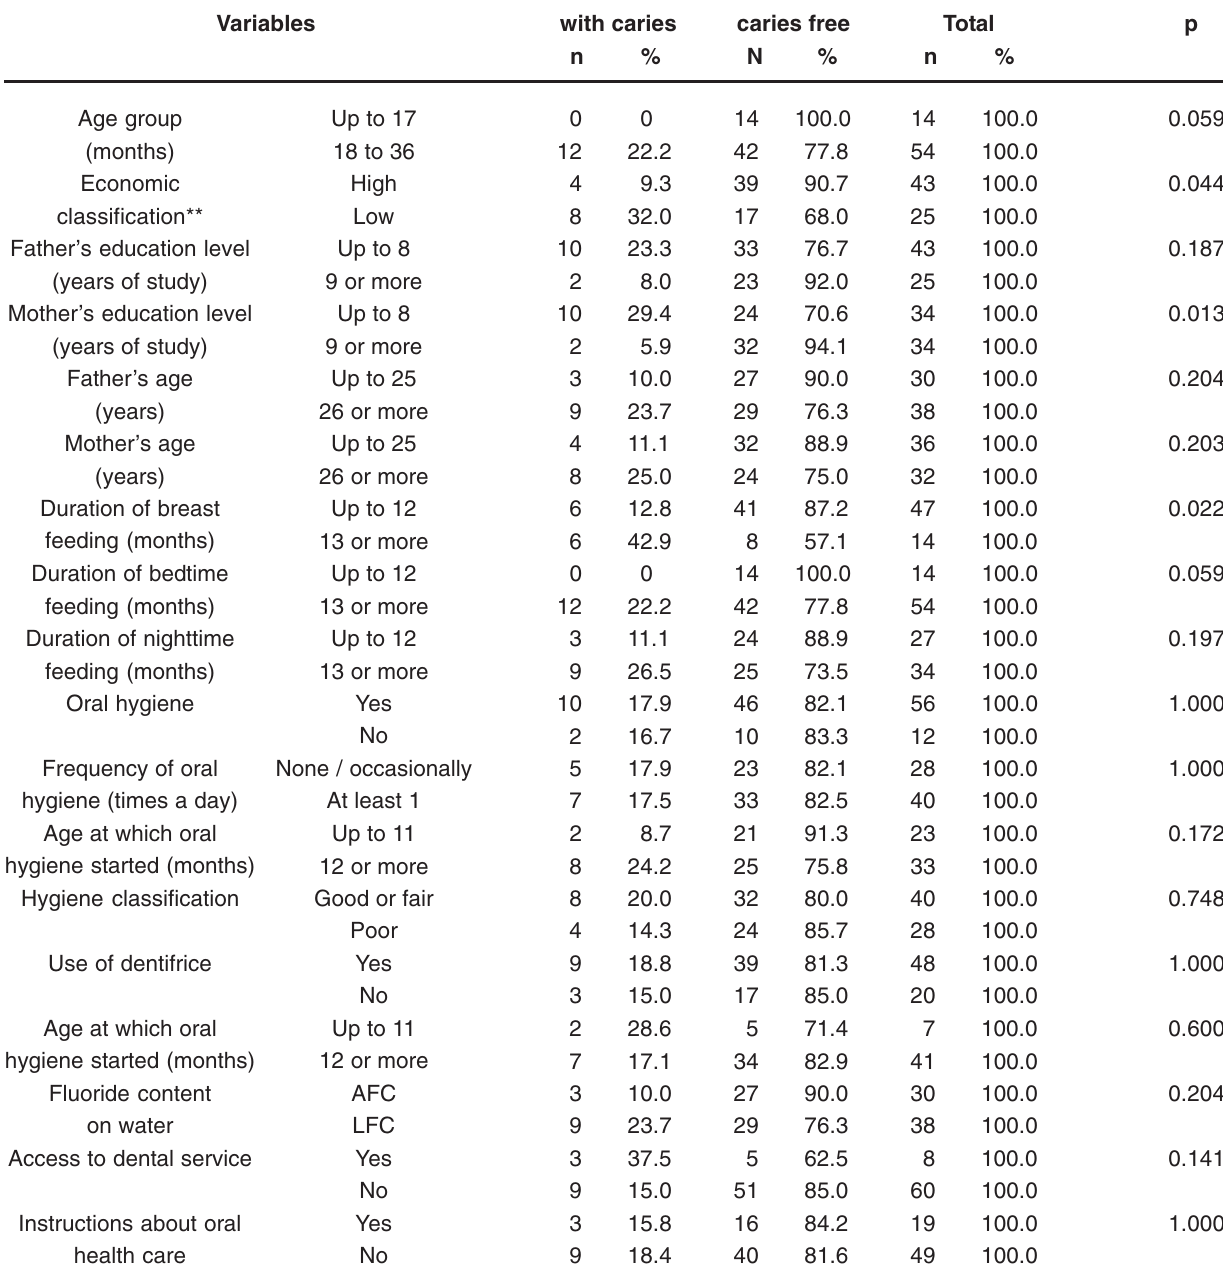
TABLE 2- CCL prevalence regarding the studied